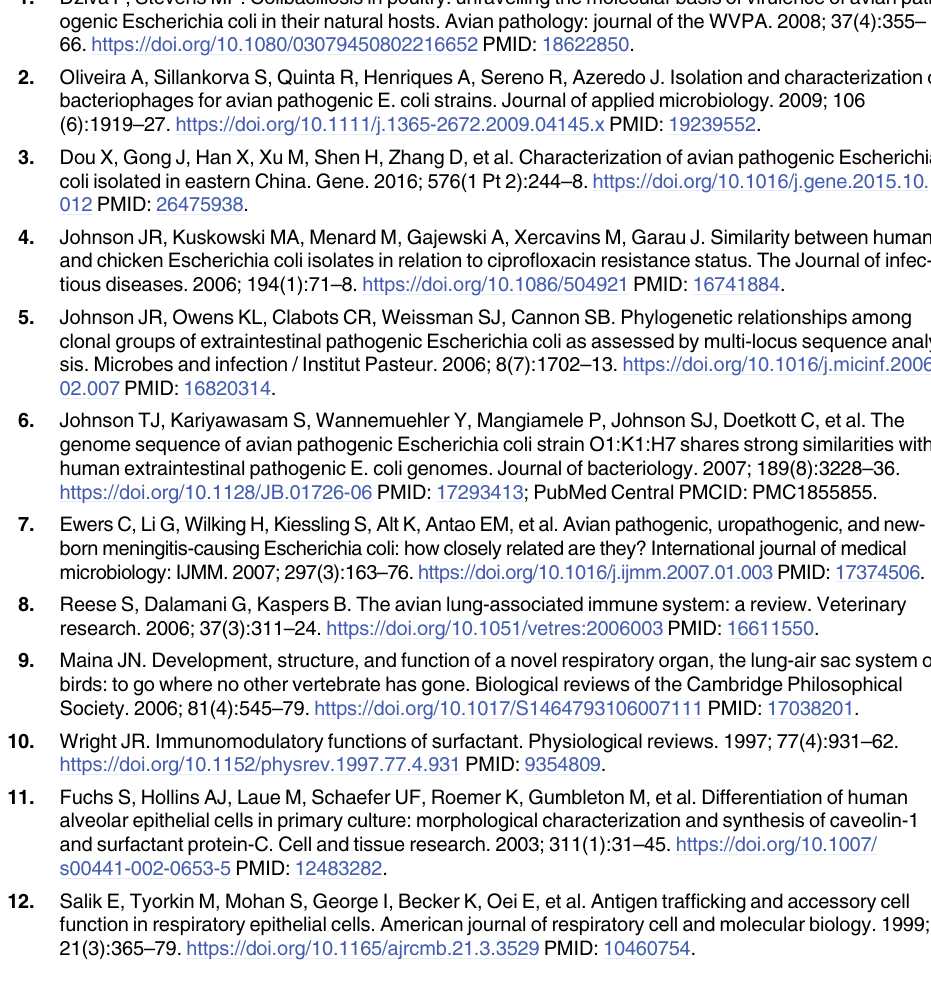
S3 Table. The RNA-seq data and data analysis. S4 Table. Selected data from the RNA-seq of chicken type II pneumocyte, with a focus on transcripts representing gallus gallus